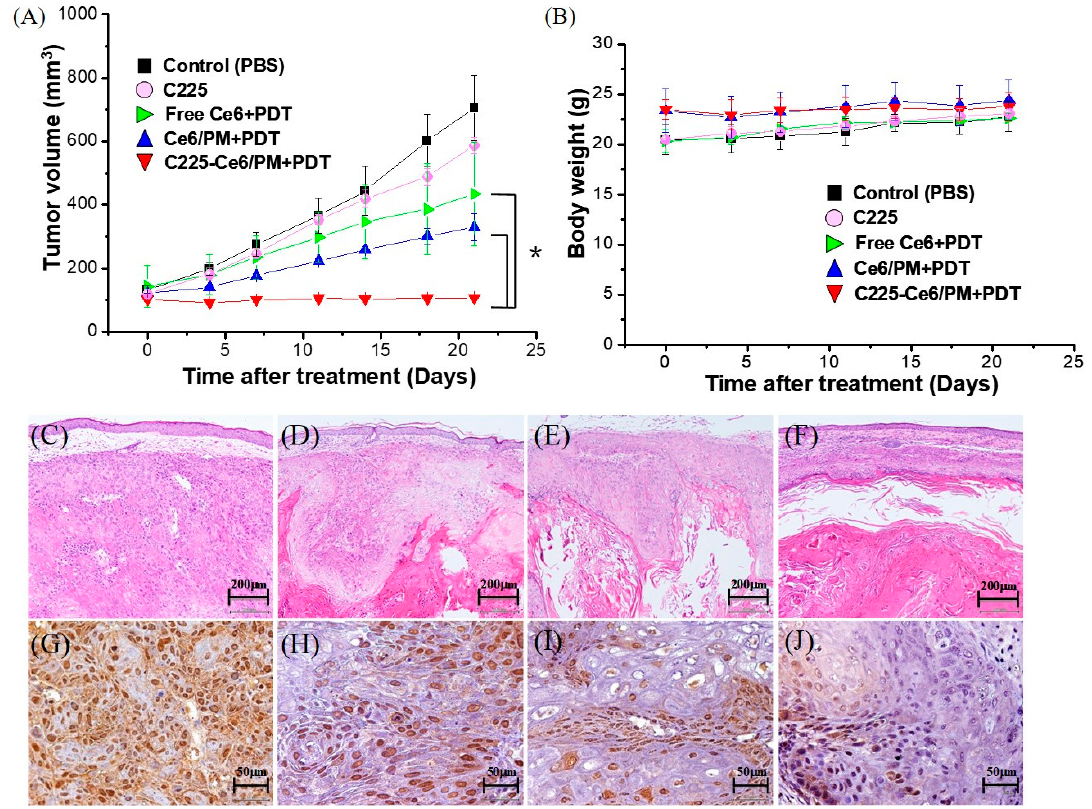
Figure 6. ( A ) Regrowth curves and ( B ) relative weight curves of A431 tumors in nude mice submitted to photodynamic therapy (PDT) treatment. The data are presented as the means ± standard deviation. * Significantly different compared with the control or non-tumor targeting PDT-treated groups ( p < 0.05). Hematoxylin and eosin (H&E) and proliferating cell nuclear antigen (PCNA) staining of A431 xenograft tumors treated with phosphate-buffered saline (PBS) or micellar Ce6 with irradiation. ( C , G ) Control. ( D , H ) Ce6-PDT; ( E , I ) Ce6-PDT/PM; ( F , J ) C225-Ce6/PM-PDT. ( C – F ): H&E staining. ( G – J ): PCNA staining.